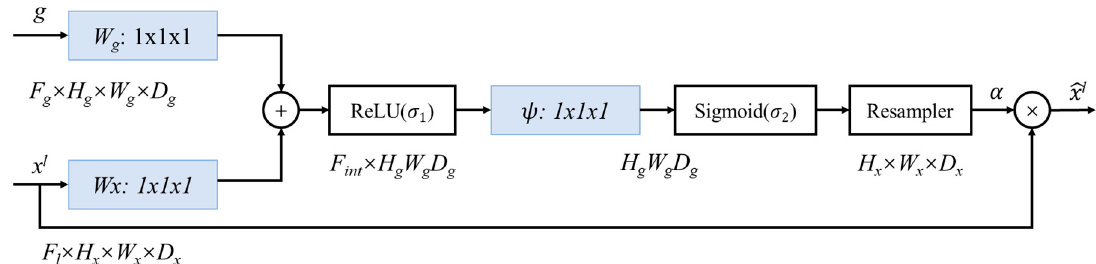
Figure 4. Attention gate structure [34]. F , H and W stand for channel, height and width respectively, and D is the depth of the 3D data block. x l , the feature map from the encoder layer, is scaled with the attention coefficients ( α ), which are computed by x l and g . The previous decoder features in g are added to x l to determine the focus regions; then, the value of the attention coefficients is between 0 and 1 throughout training.